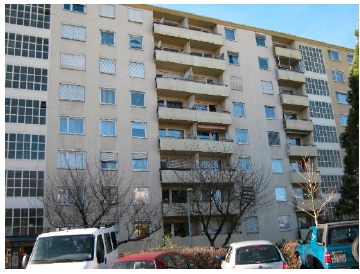
Figure 2. The building under renovation in the Weingarten West area of Freiburg (Germany).